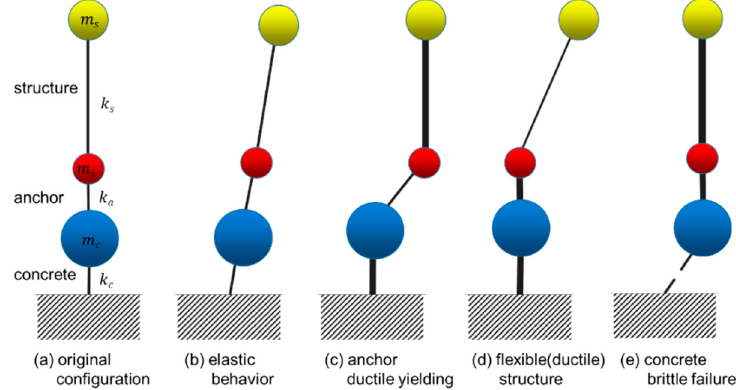
Figure 7. Pushover simulations for different failure mechanisms. Figure 8a shows the lateral force vs. displacement curve under various failure scenarios.